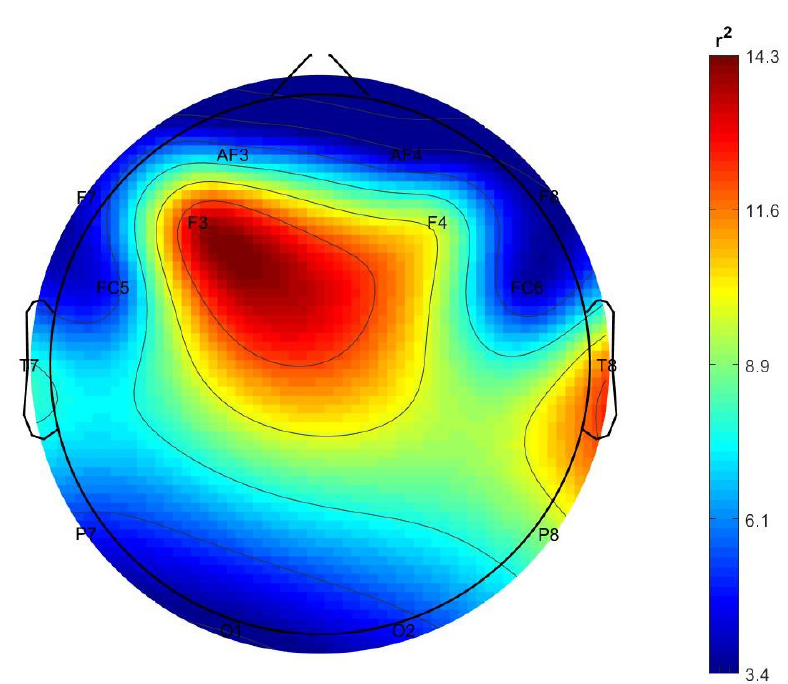
Figure 1. Topographic distribution of r 2 coefficients (stimulation vs non-stimulation discriminative power) in the stimulated participants.